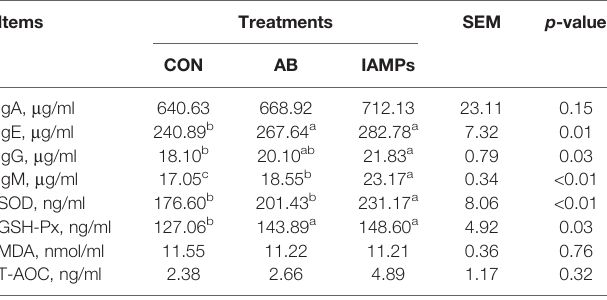
TABLE 4 | Effects of IAMPs on serum biochemical index of weaning pigs.